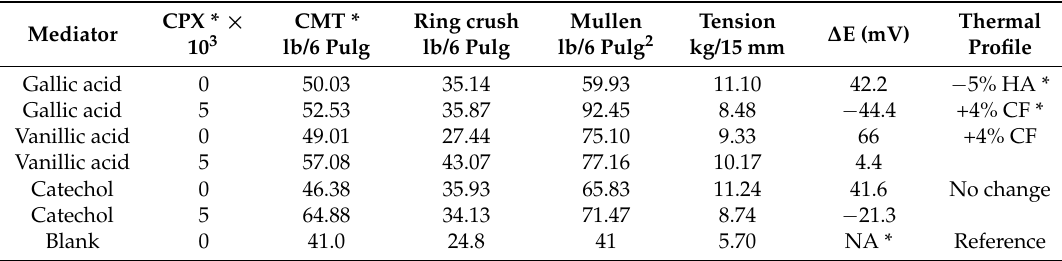
Table 1. Redox potential and mechanical properties for the papers